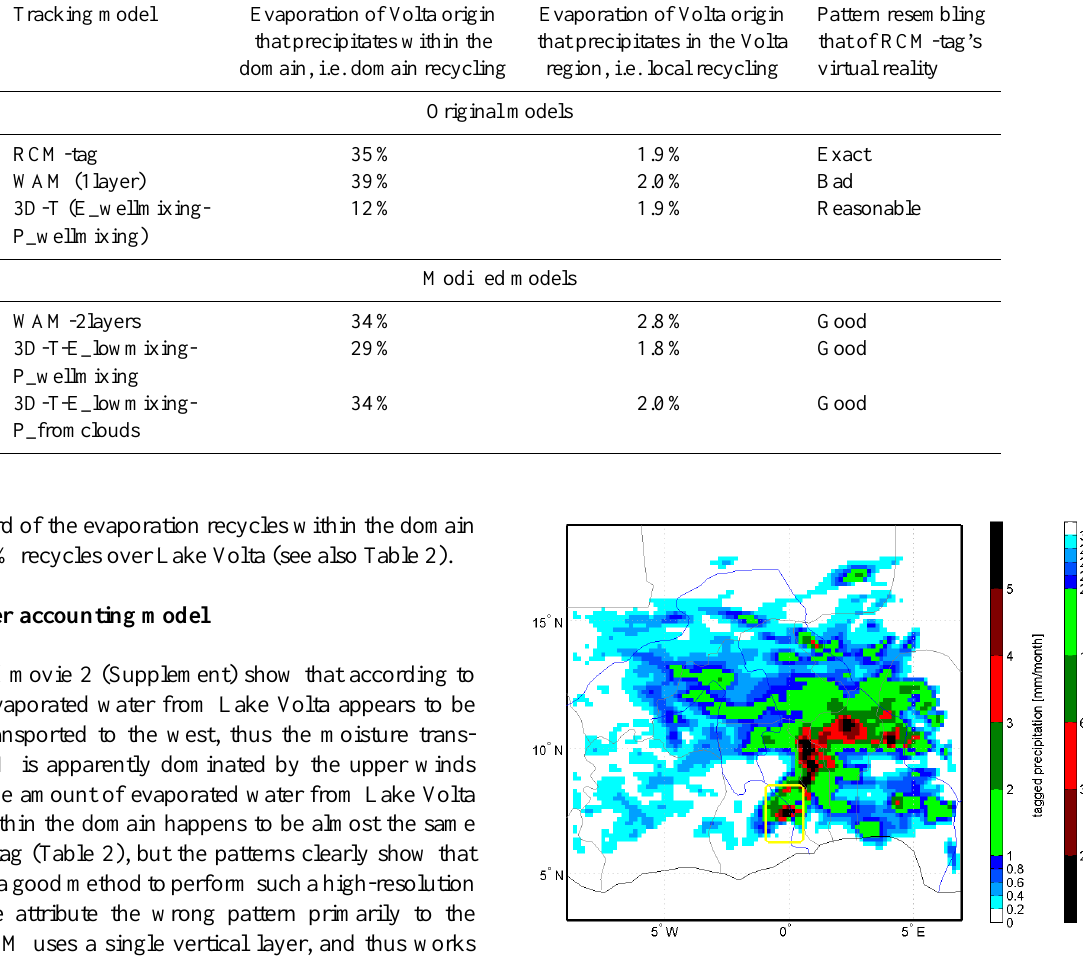
Fig. 3. Precipitation of Volta origin in August 1998 as computed by RCM-tag. The yellow rectangle indicates the Lake Volta tagging- source region. The left colour bar indicates the absolute amount of precipitation that originated from Lake Volta. The right colour bar indicates for which percentage the precipitation in the coloured ar- eas accounts for the evaporation from the tagging-source region. For example, the light green regions receive 1 to 2mmmonth − 1 of pre- cipitation that originated from Lake Volta, and in total the tagged precipitation in the light green areas sums up to 20 − 11=9% of Lake Volta’s